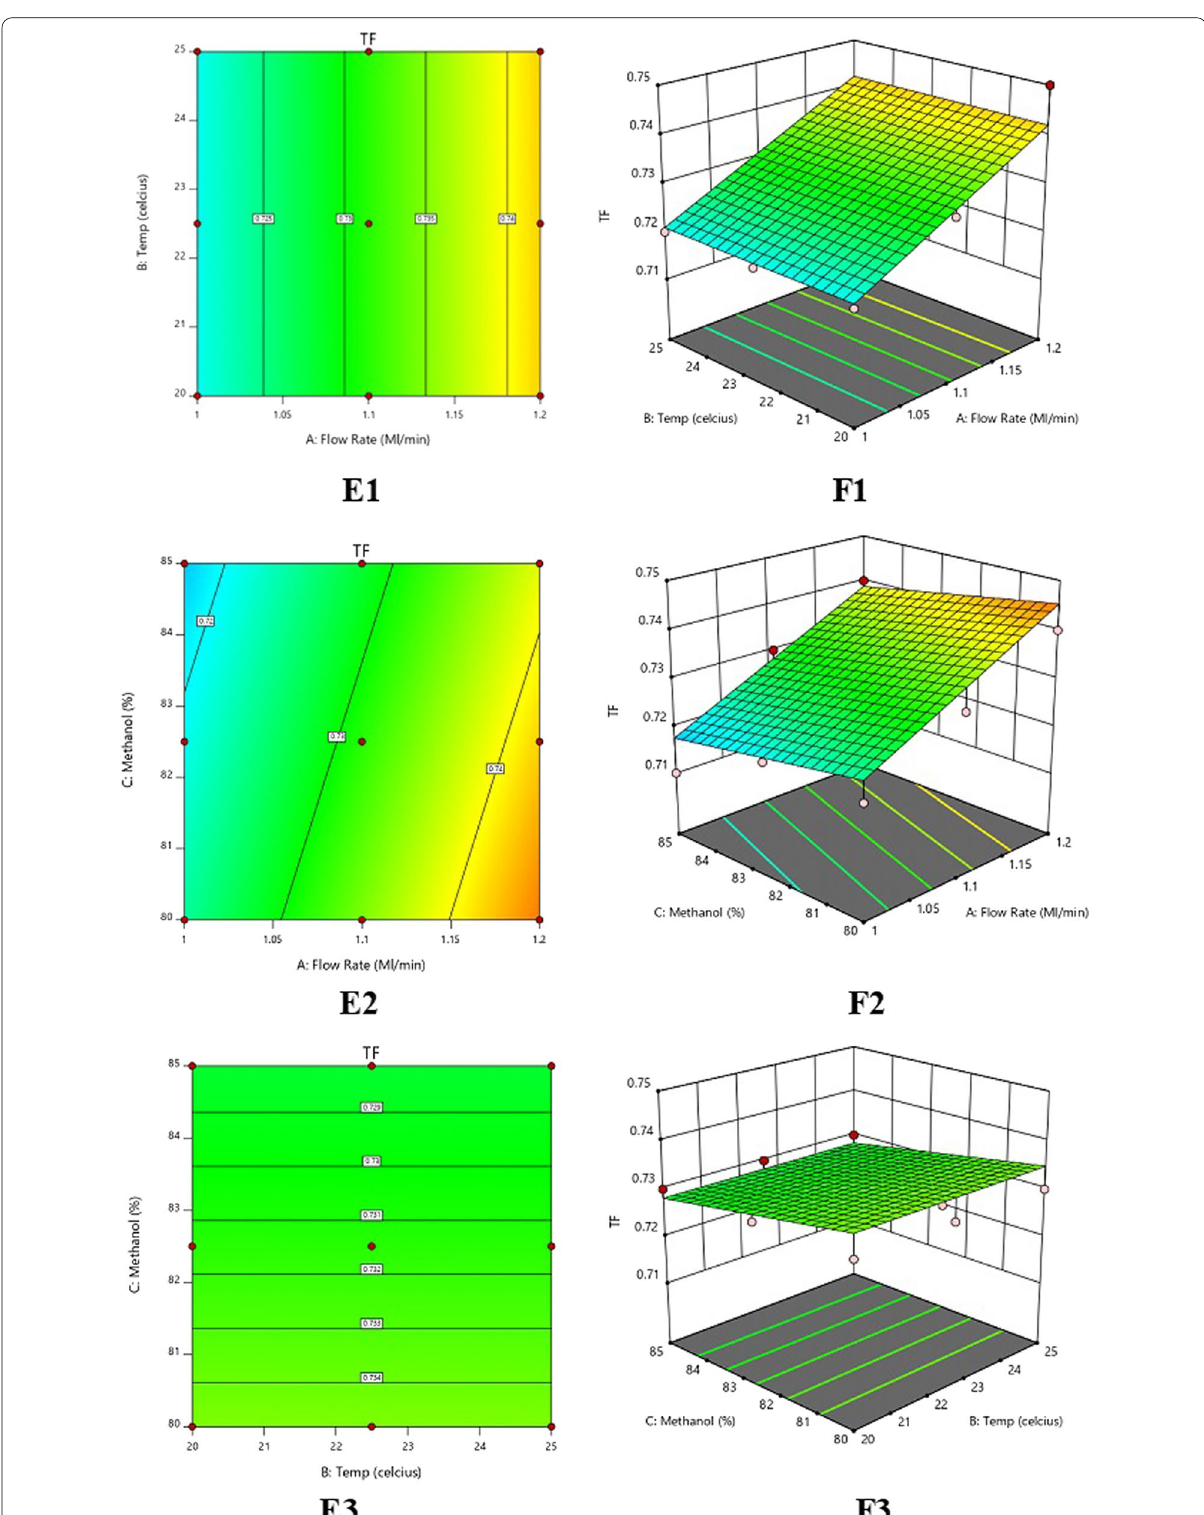
Fig. 7 Relation plot (E1-E3; F1-F3) between actual with predicted values and residual plot for